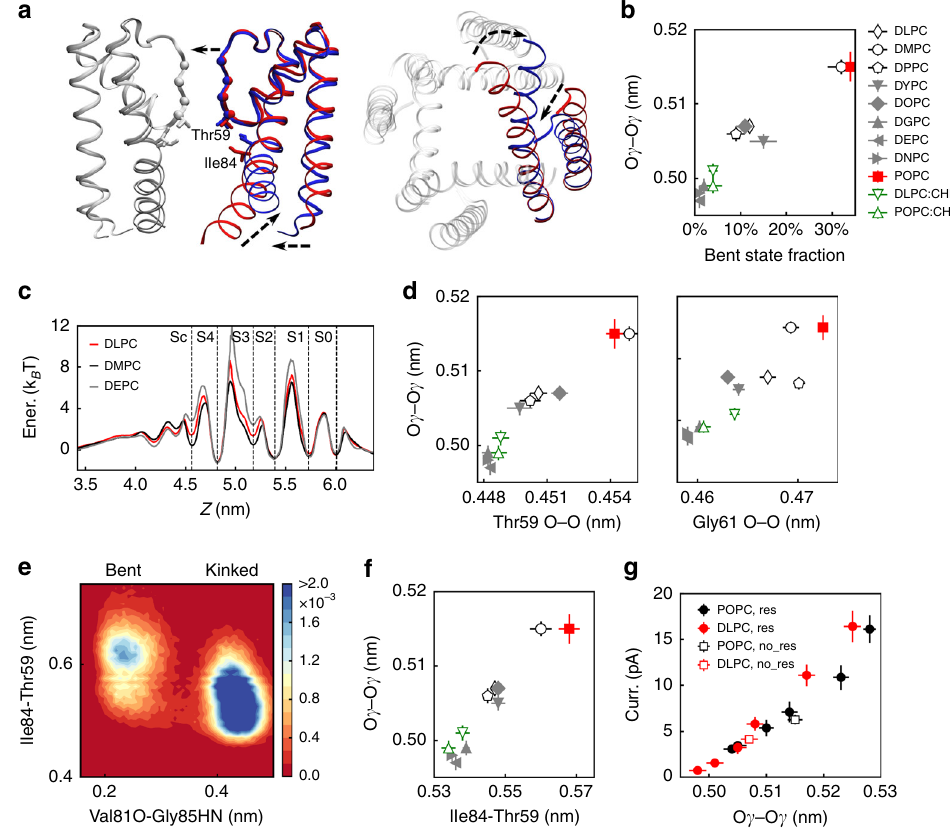
Fig. 4 Gating of the selectivity fi lter by the kink of the inner helix. Panels ( b ), ( d ), and ( f ) share the same legend. a Side (left) and top (right) view of two extreme conformations from functional mode analysis (FMA), which correspond to the kinked (blue) and the bent (red) states. Directions of conformational changes are indicated by dashed arrows. The subunit whose bending angle was used to decode the collective motions is shown in red and blue, whereas the other subunits are depicted in gray. b Correlation between Thr59 O γ – O γ distance and bent-state fraction of the channel in simulations using different membranes. c Potassium “ free energy ” pro fi les along the ion permeation pathway in DLPC (red), DMPC (black), and DEPC (gray) membranes. Potassium-binding sites are indicated with dashed lines. d Correlation between Thr59 O γ – O γ distance and the backbone oxygen atom distance of Thr59 (left panel) and Gly61 (right panel) in simulations using different membranes. e Histogram as a function of the Ile84 – Thr59 side-chain distance and the Val81O – Gly85HN distance. f Thr59 O γ – O γ distance as a function of the Ile84 – Thr59 side-chain distance in simulations using different membranes. g Ion current as a function of the Thr59 O γ – O γ distance in simulations restraining the Ile84 side-chain distances in POPC and DLPC membranes ( fi lled symbols). Data from unrestrained simulations are also shown for comparison (open symbols). Number of independent replicates for each data point in panels ( b ), ( d ), and ( f ) is the same with Fig. 2. Ten independent simulations were performed for each data point of the restrained simulations in panel ( g ), except for the simulation in POPC with an average Thr59 O γ – O γ distance of 0.528 nm, which includes 20 independent replicates. Data are presented as mean values ± SEM. Source data are available as a Source Data fi